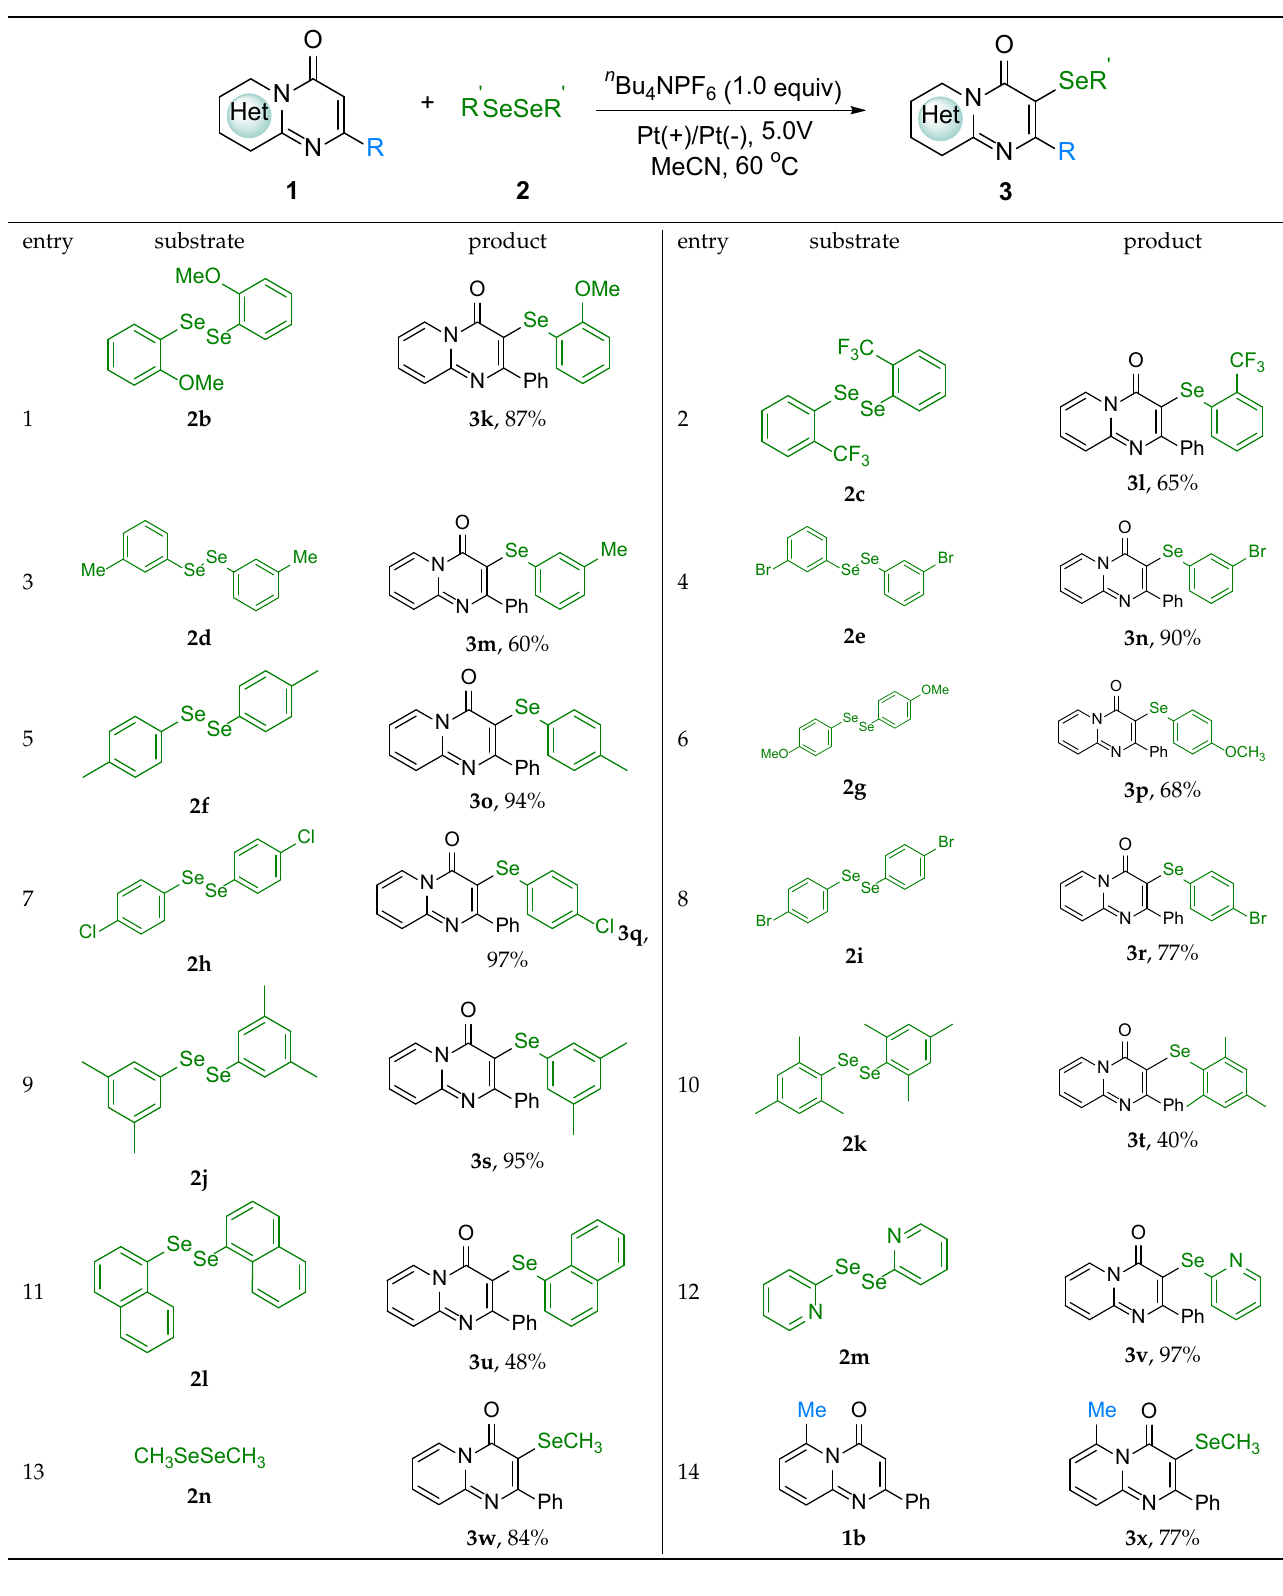
Table 3. Substrate scope of diselenides and pyrido[1,2- a ]pyrimidin-4-ones a,b,c,d,e .